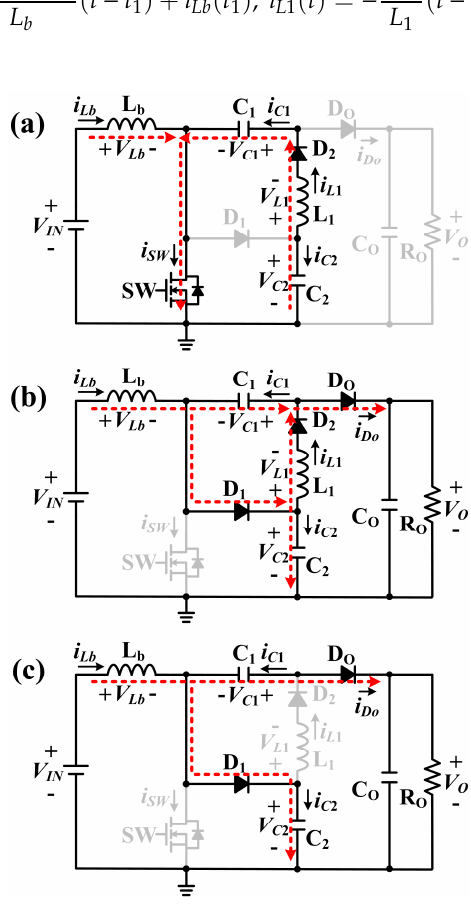
Figure 4. Modes of operation: ( a ) Mode 1 ( t 0 < t < t 1 ), ( b ) Mode 2 ( t 1 < t < t 2 ), ( c ) Mode 3 ( t 2 < t < t 3 ).